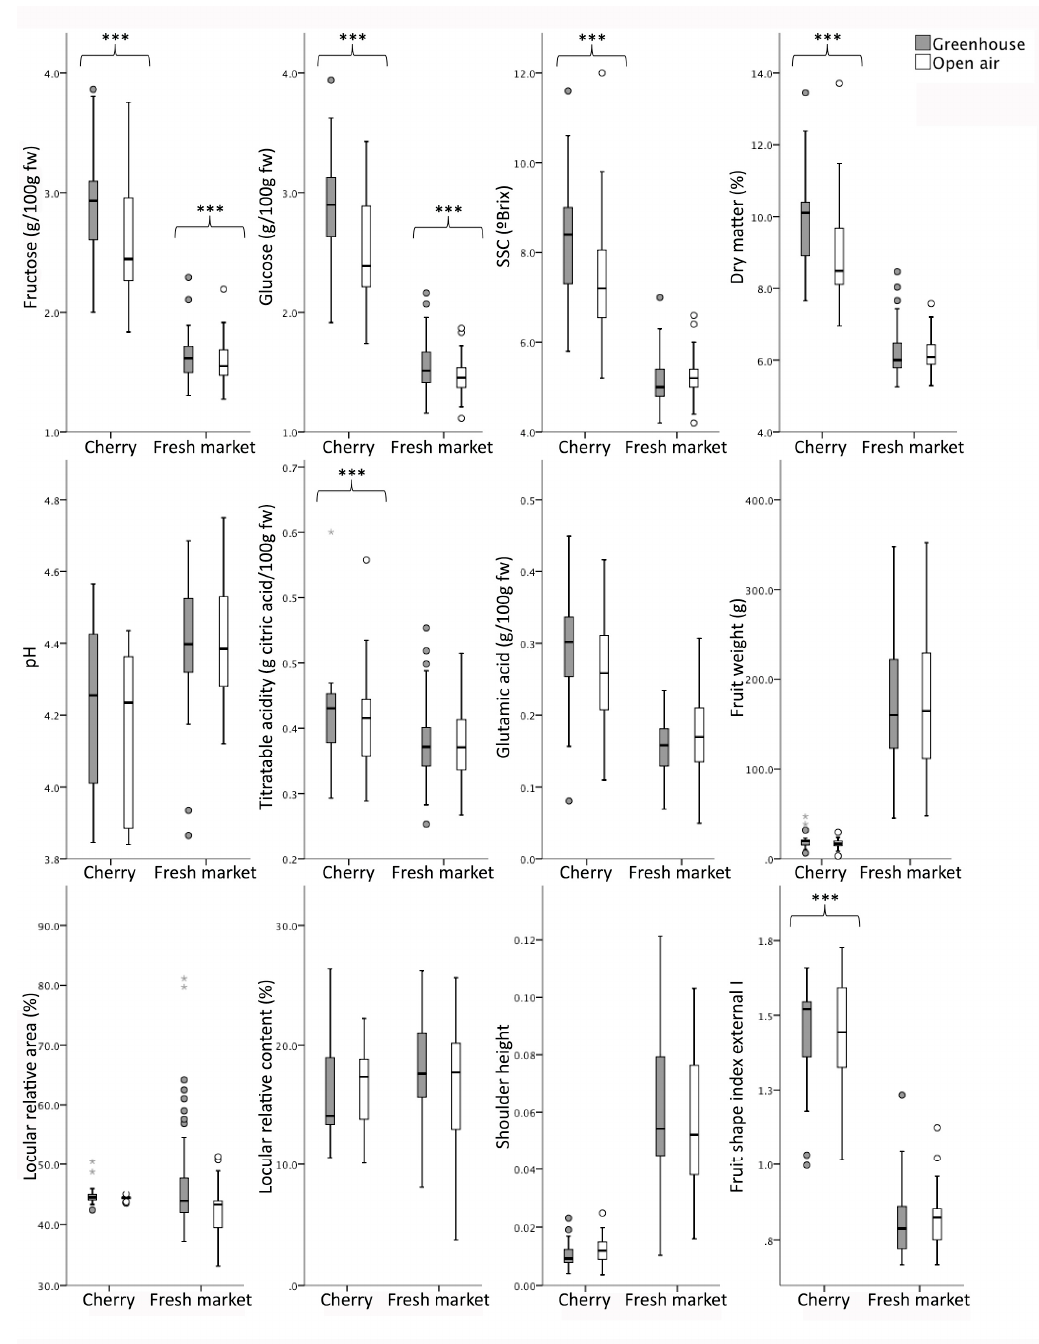
Figure 2. Genetic diversity within cherry and fresh market tomatoes for the most important chemical and morphological traits, and comparison between greenhouse and open-air cultivation. For the boxplots, ° and * represent extreme values more than 1.5×, and 3.5×, respectively, of the interquartile range of the box, which contains the middle 50% of the records. Significant differences between environments for each group are signaled above a bracket (significance levels, *** p < 0.001, ** p < 0.01, * p < 0.05).